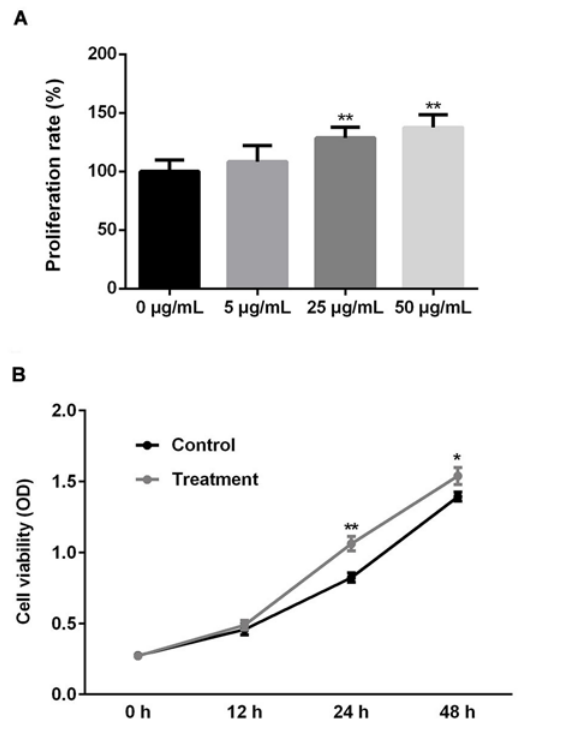
Figure 1: Effect of PM2.5 on the growth of human SMMC-7721 cells (A) SMMC-7721 cells were cultured in the presence of various con- centrations (5, 25, 50μg/ml) of PM2.5 for 24 h. Cell proliferation was measured by CCK8 assay. The optical density was then measured at 450 nm and the results were presented as percentage of control (arbitrarily set at 100%). All data shown are the of three separate experiments. (B) SMMC-7721 cells were cultured in the presence of 25 μg/ml PM2.5 for different time (12, 24, 48h). Cell proliferation was measured by CCK8 assay. The data were shown as the optical density measured at 450 nm. All data shown are the of three sepa- rate experiments. *, p < 0.05, **, p <